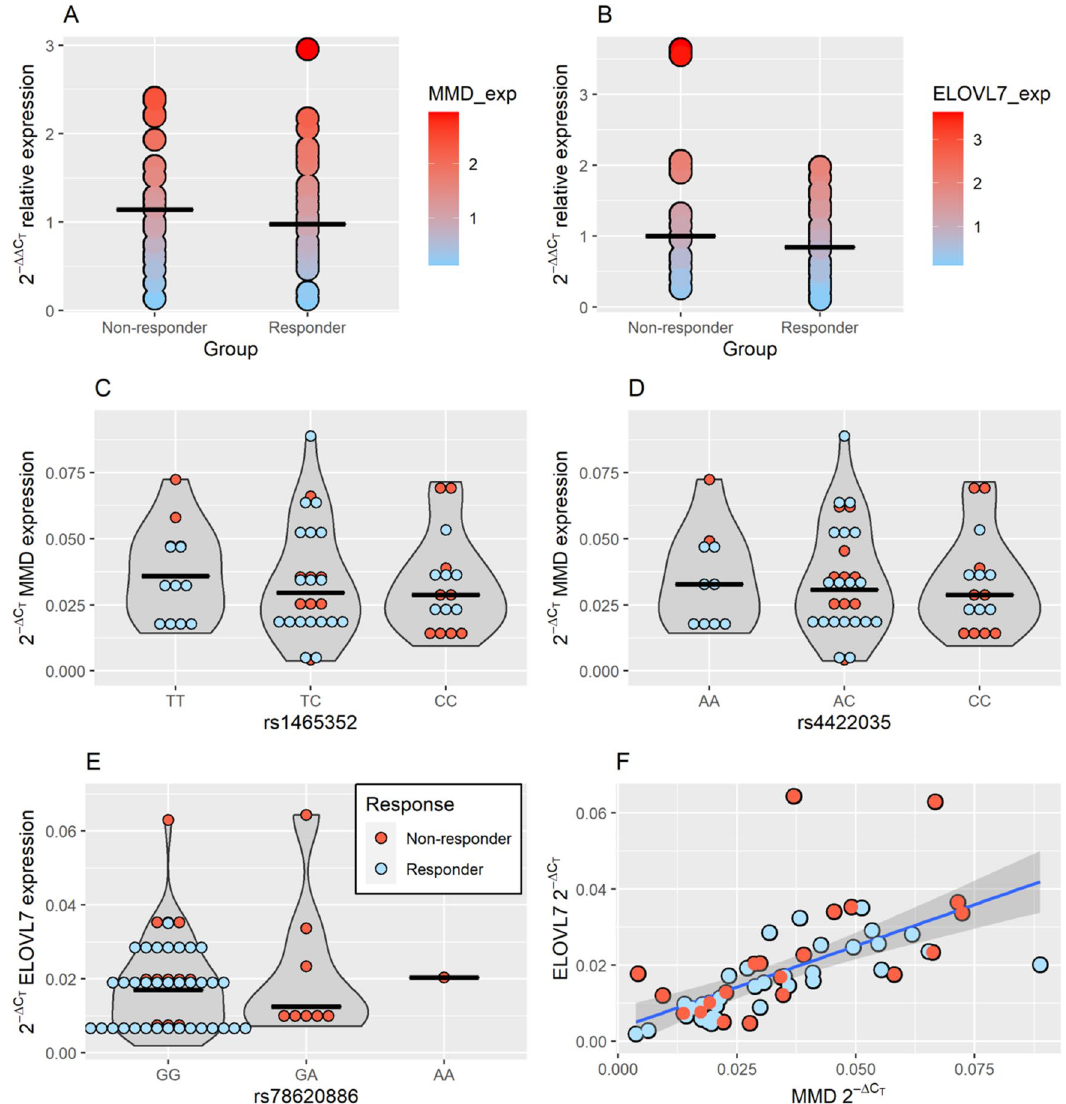
Figure 4. Validation of results using RT-qPCR, eQTL analysis and correlation estimation. ( A ) MMD relative expression; ( B ) ELOVL7 relative expression; ( C ) eQTL for rs1465352 and MMD ; ( D ) eQTL for rs4422035 and MMD ; ( E ) eQTL for rs78620886 and ELOVL7 ; ( F ) Correlation between MMD and ELOVL7 expression. Black lines represent median expression. Blue line represents correlation regression curve with standard error. The plots were constructed using ggplot2 R package 23